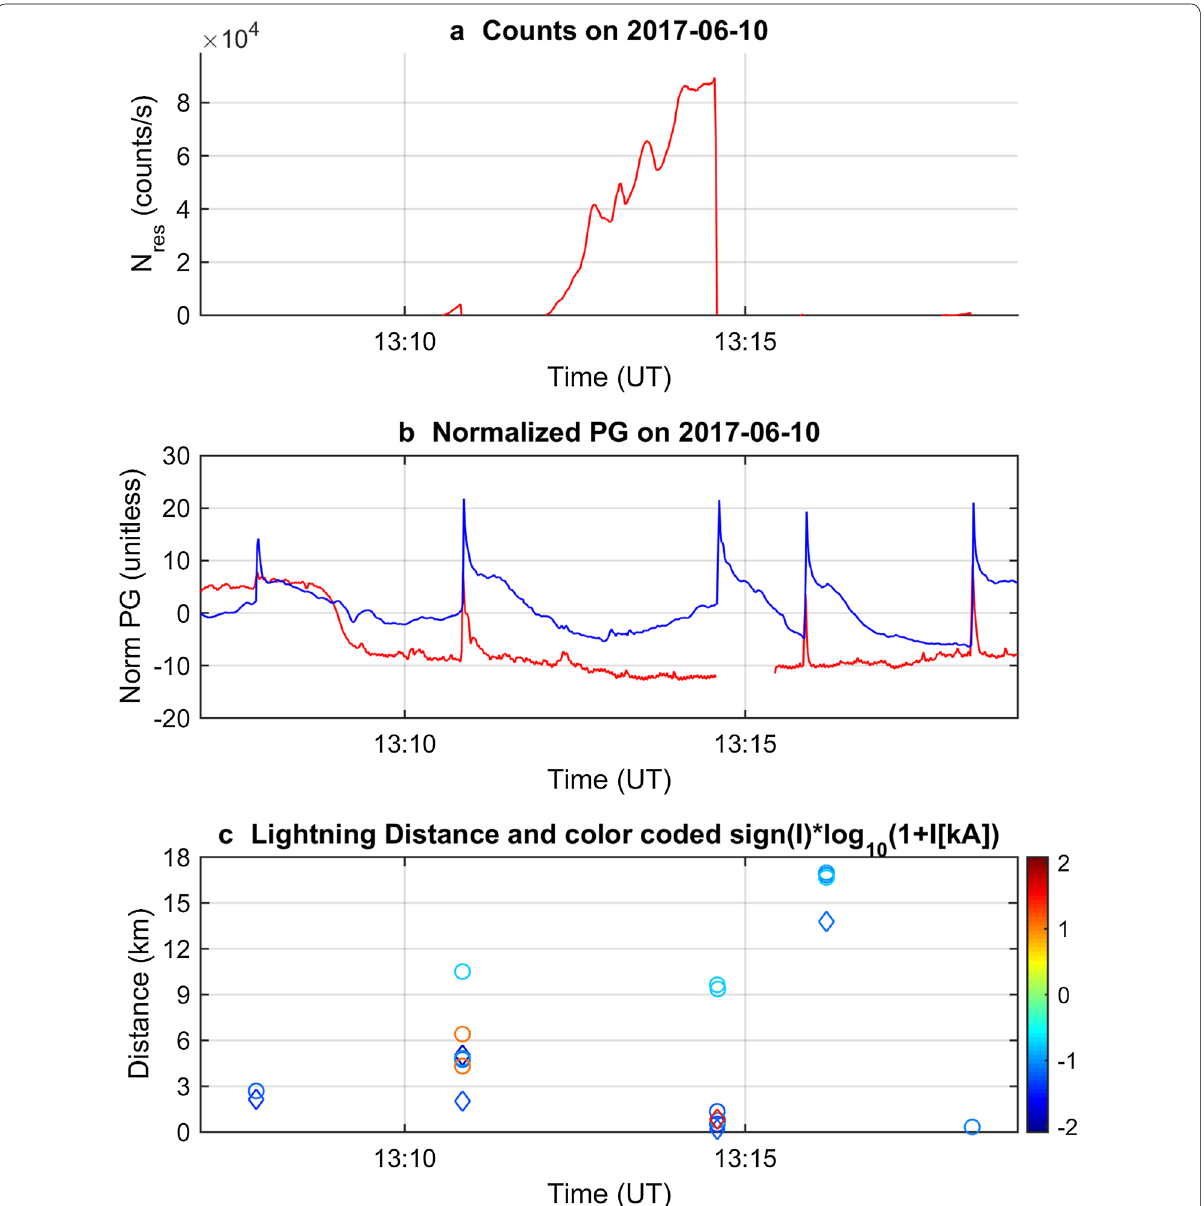
Fig. 10 Extreme event recorded on 10 June 2017 around 13:13 UT. a Residual counts at Lomnicky peak by red. b Normalized PG at Lomnicky peak (red) and Skalnate Pleso (blue). c Lightning distances from Lomnicky peak as recorded by EUCLID lightning detection network; CG discharges are by diamonds, IC by circles, peak current I is color-coded; the color approximately corresponds to the common logarithm of the peak current in kA, sign of the current is